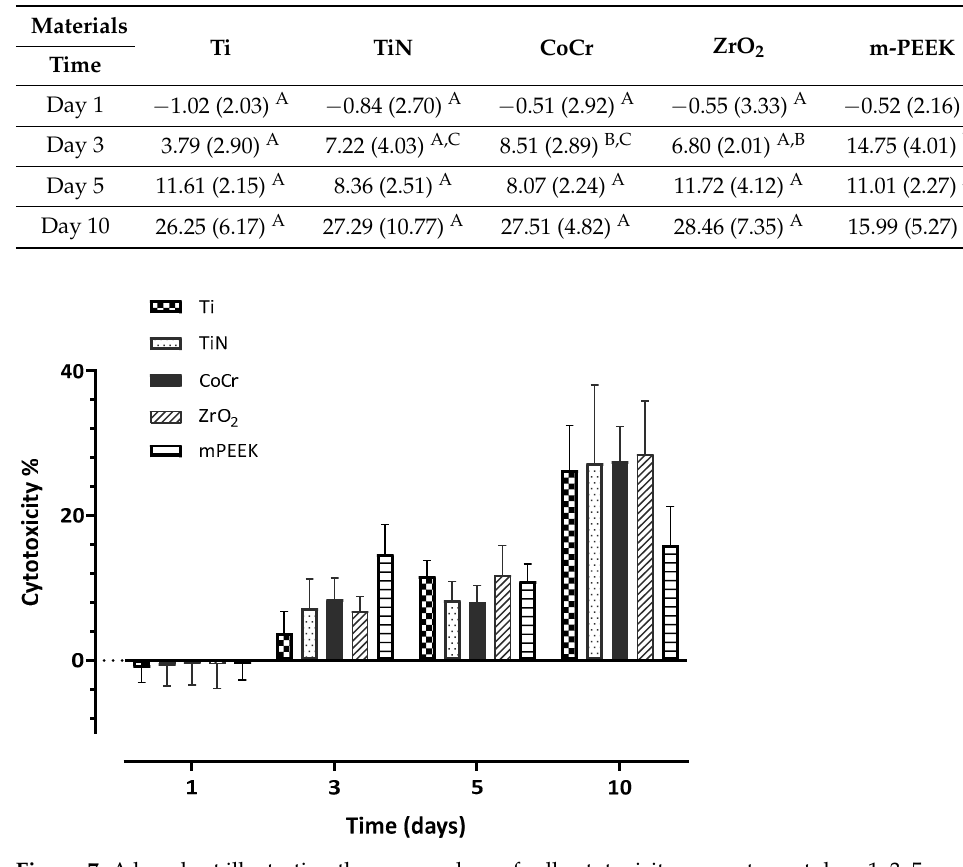
Figure 7. A bar chart illustrating the mean values of cell cytotoxicity percentage at days 1, 3, 5, and 10 for HGFB. Error bars represent the standard deviation. Both assays were compared for each material over each time point for both cell lines (Figures 8 and 9). In HGKC, a nonsignificant positive correlation for Ti, TiN, and m-PEEK and a significant positive correlation for CoCr ( p = 0.004) and ZrO 2 ( p = 0.008) were found between viability and cytotoxicity. While in HGFB, a nonsignificant negative correlation between viability and cytotoxicity was found for all tested materials. HGKC cell proliferation was higher than that of HGFB at days 1, 3, and 5 for Ti, TiN, and CoCr. Conversely, cell proliferation of HGFB was higher than that of HGKC through- out the whole experiment for ZrO 2 and m-PEEK, with m-PEEK exhibiting the highest cell proliferation percentage for HGFB, while TiN exhibited the highest percentage for HGKC at day 10 (Tables 2 and 3). These results were generally reversed for cytotoxicity, with HGFB showing an initial very low cytotoxicity that then increased gradually throughout the experiment to reach the end of 20 s for all materials, except m-PEEK (Table 5). On the other hand, HGKC showed initially high cytotoxicity to all materials, which decreased from days 3 to 5 and then increased at day 10 for all materials, except for ZrO 2 , which exhibited the lowest cy- totoxicity level at day 10 (Table 4).